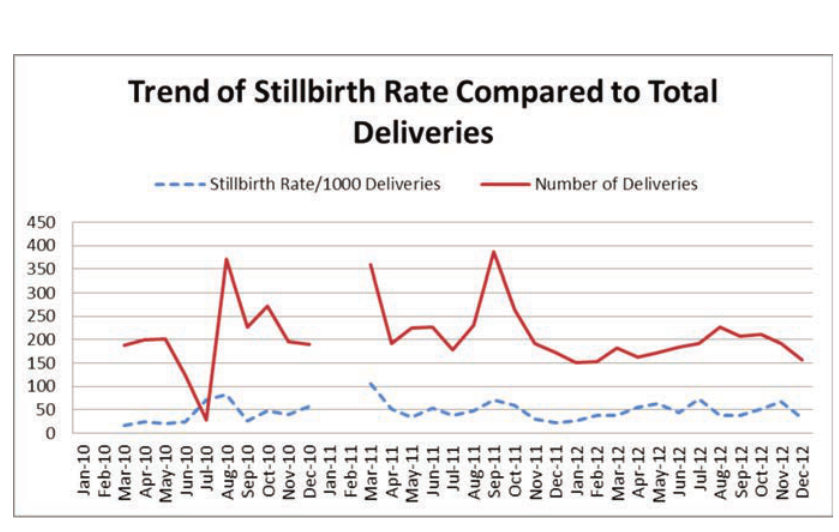
Figure 1. Trend of stillbirth rate compared to total